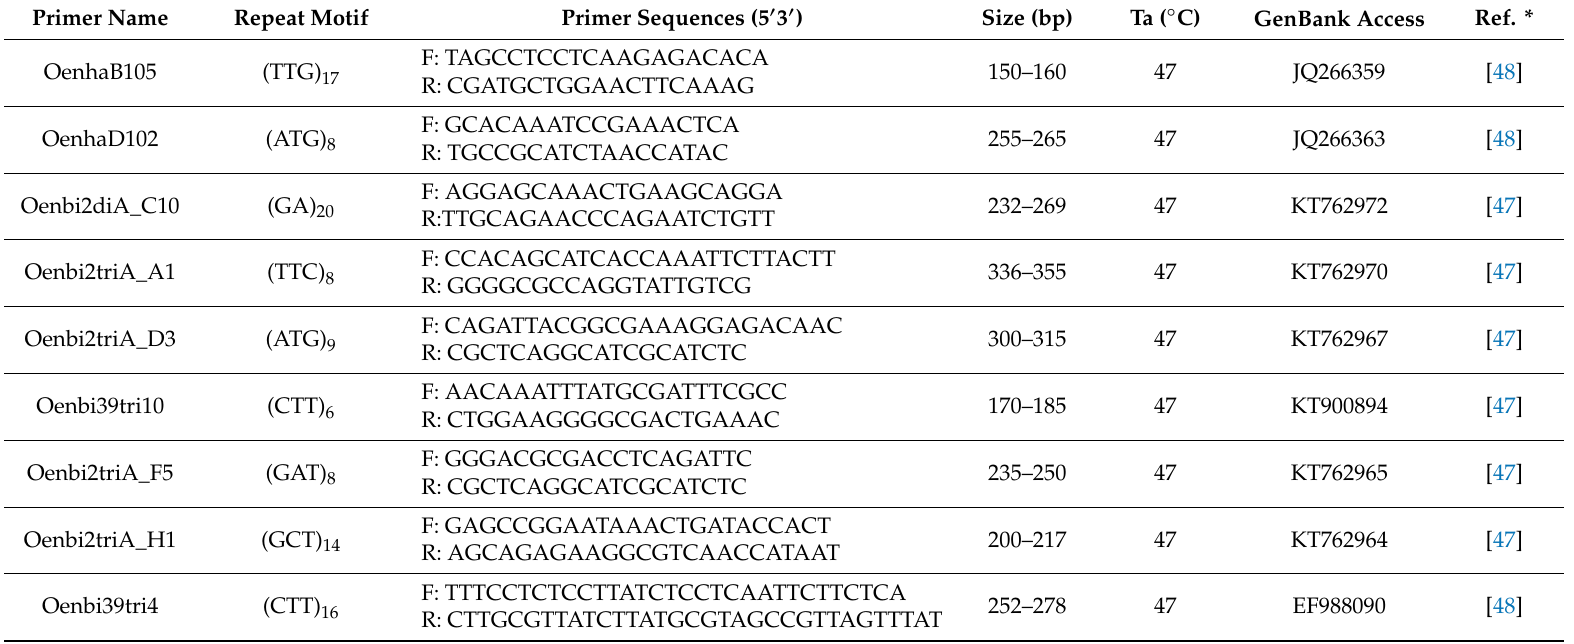
Table 2. Characteristics of nine microsatellite primers tested on Oenothera drummondii populations; seven primers were developed in O. harringtonii and three in O. biennis